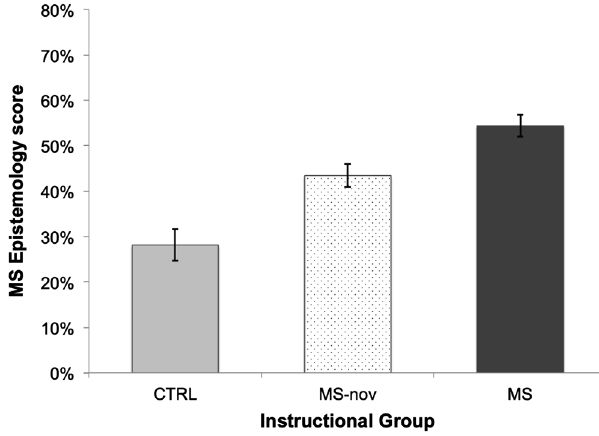
FIG. 7. Scatterplot of number of crossover approaches used vs MS epistemology score, with the model fit plotted for each instructional